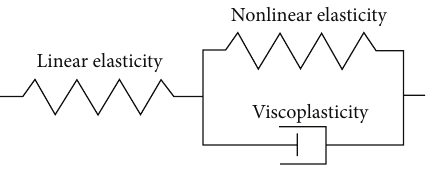
Figure 4: Standard rheology used to describe the large strain range of glassy polymers [18].